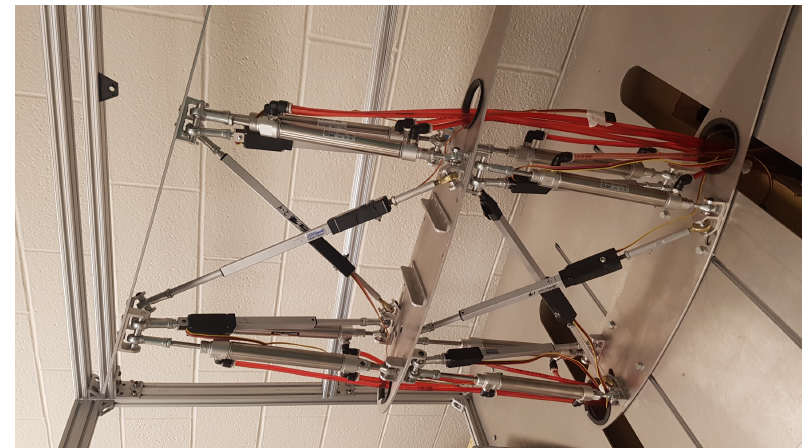
Figure 1. Reconfigurable modular morphing wing, view 1.